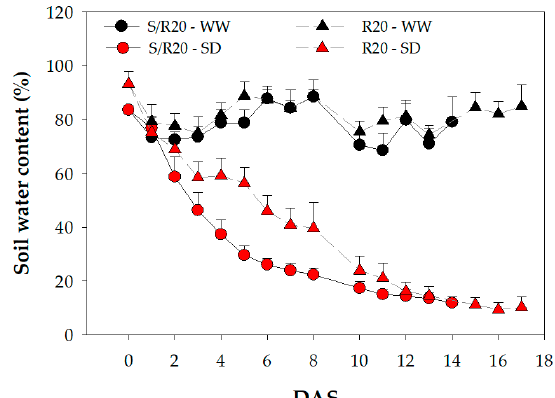
Figure 1. Evolution of the substrate water content (%) during the desiccation experiments for the R20 (triangles) and S/R20 (circles) Prunus dulcis cultivars with well-watered treatment (WW, symbols in black) and substrate desiccation treatment (SD, symbols in red). The symbols indicate the mean + standard deviation. DAS: days after stress. Table 1. Values of key metrics for describing an-/isohydric behavior in the S/R20 and R20 cultivars. The traits are shown either in mean ± standard error of the mean or values with lower and upper bounds of a 95% confidence interval (bracketed). σ : slope of the relationship between Ψ pd and Ψ min ; P gs90 : leaf water potential causing 90% stomatal closure; ΔΨ : maximum range of daily leaf water potential variation; A irr : maximal photosynthetic rate in irrigated plants; gs irr : maximal stomatal conductance rate in irrigated plants . Different letters indicate significant differences between cultivars at p < 0.05 according to Student’s t -test.